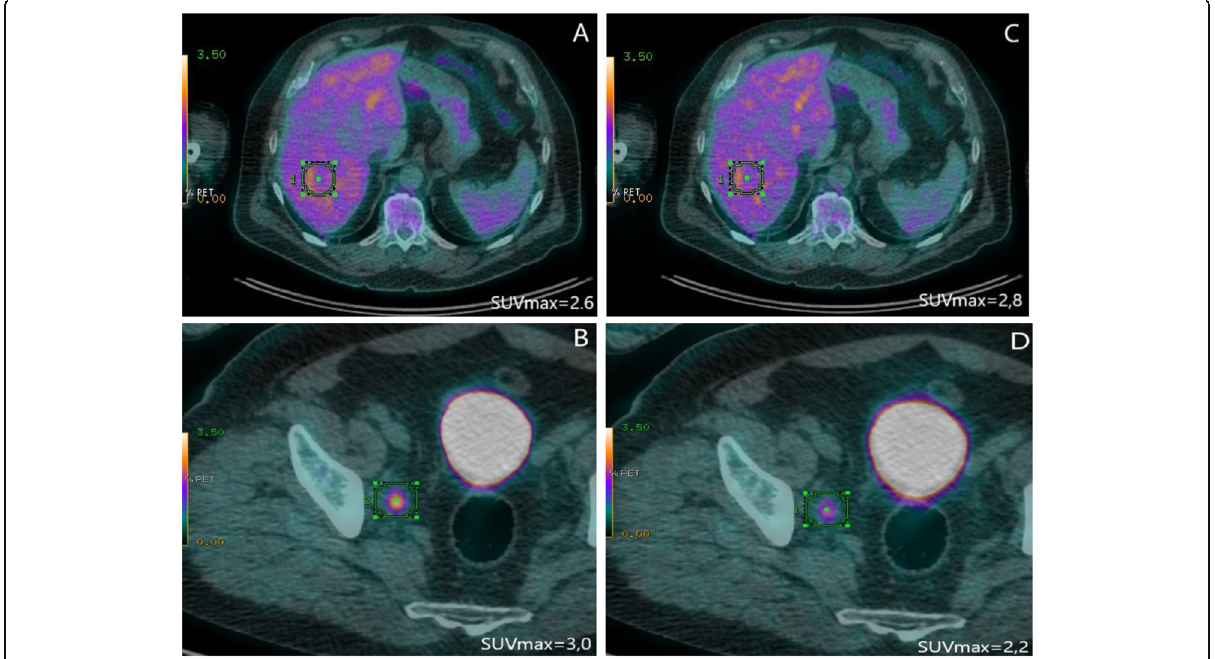
Fig. 2 SUVmax values in the liver ( a ) and in the target lesion ( b ) using Q.Clear, and liver ( c ) and the target lesion ( d ) using OSEM